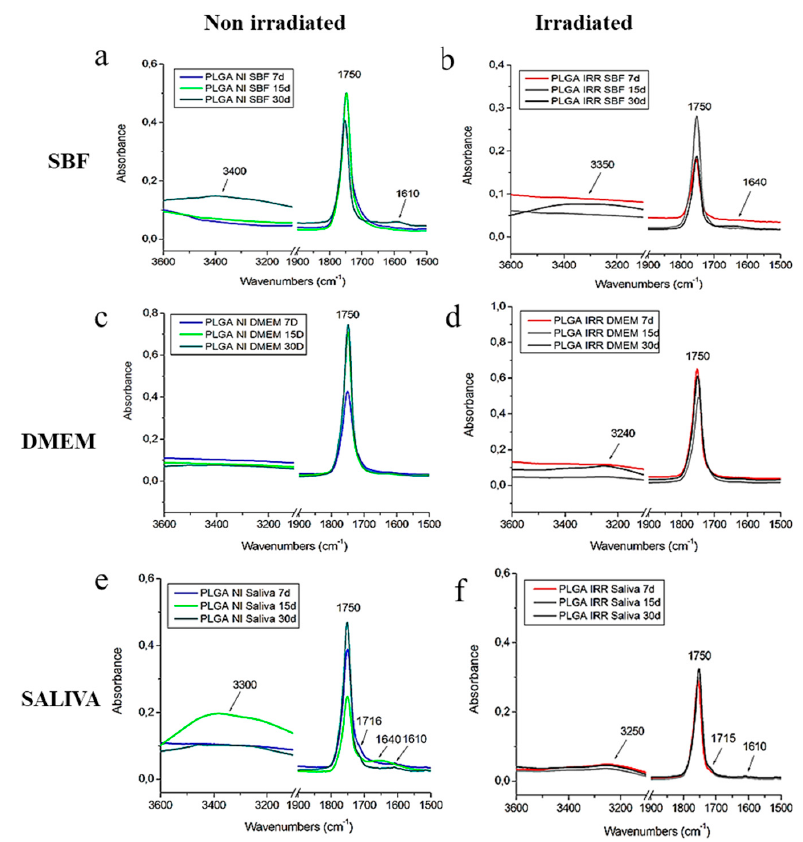
Figure 7. Normalized FTIR-ATR spectra of PLGA non irradiated and irradiated nonwovens after 7, 15 and 30 days immersed in SBF, DMEM and artificial saliva at 37 ◦ C: ( a , c , e ) gamma non irradiated PLGA. ( b , d , f ) Gamma irradiated